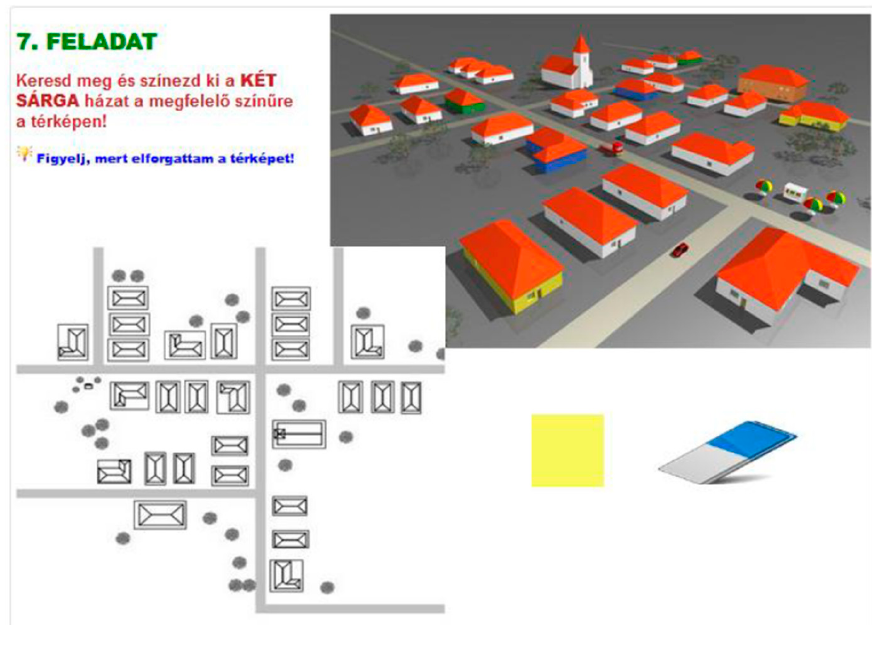
Figure 5. The assignment of Task 7.